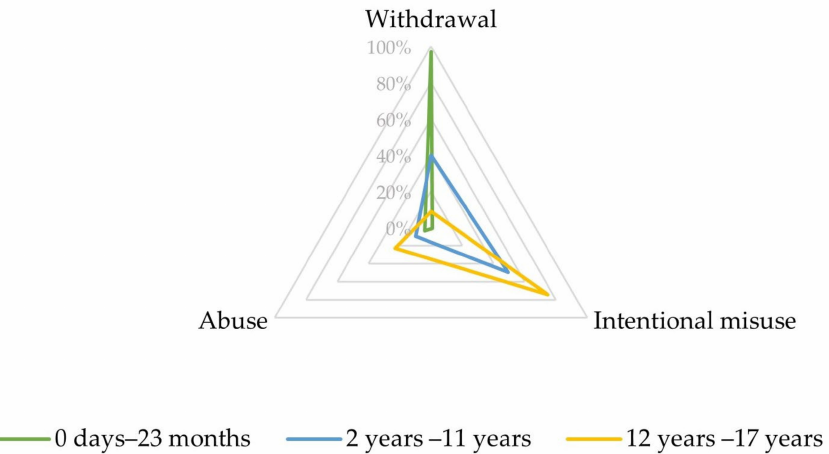
Figure 2. Characteristics of the combined Preferred Terms (PTs) ‘abuse’, ‘intentional misuse’, and ‘withdrawal’ depending on